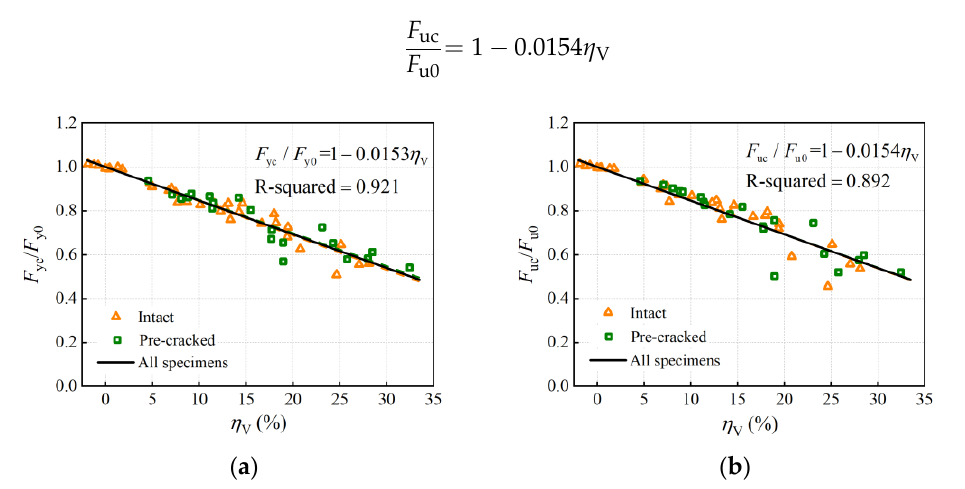
Figure 10. Effect of corrosion on load-bearing capacity: ( a ) yield load; ( b ) ultimate load.